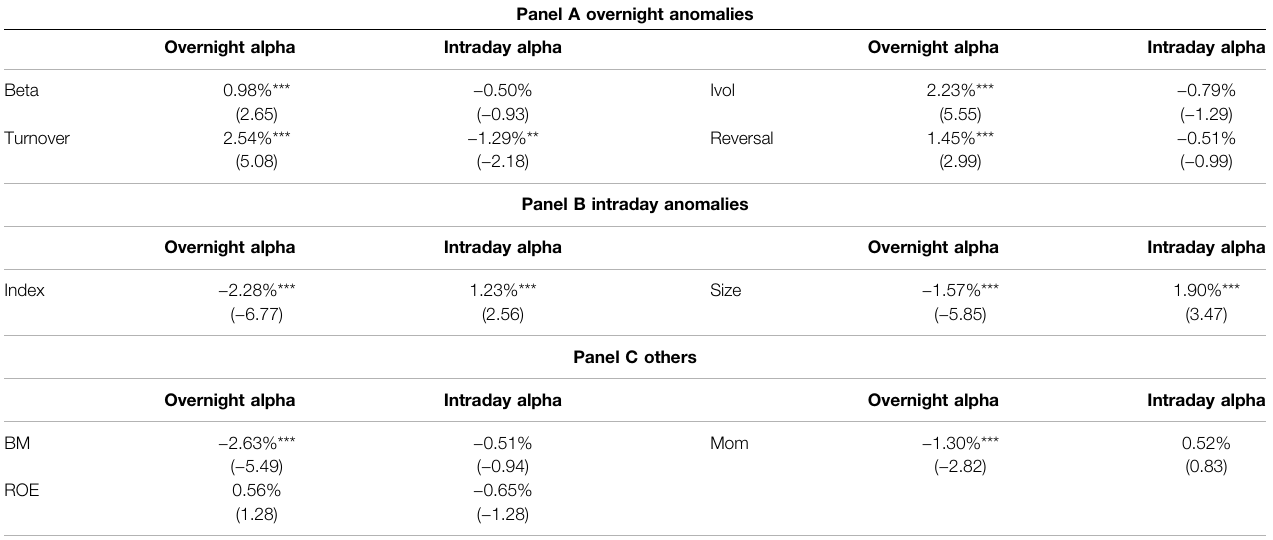
TABLE 4 | Overnight-intraday abnormal return of anomalies for energy industry stocks